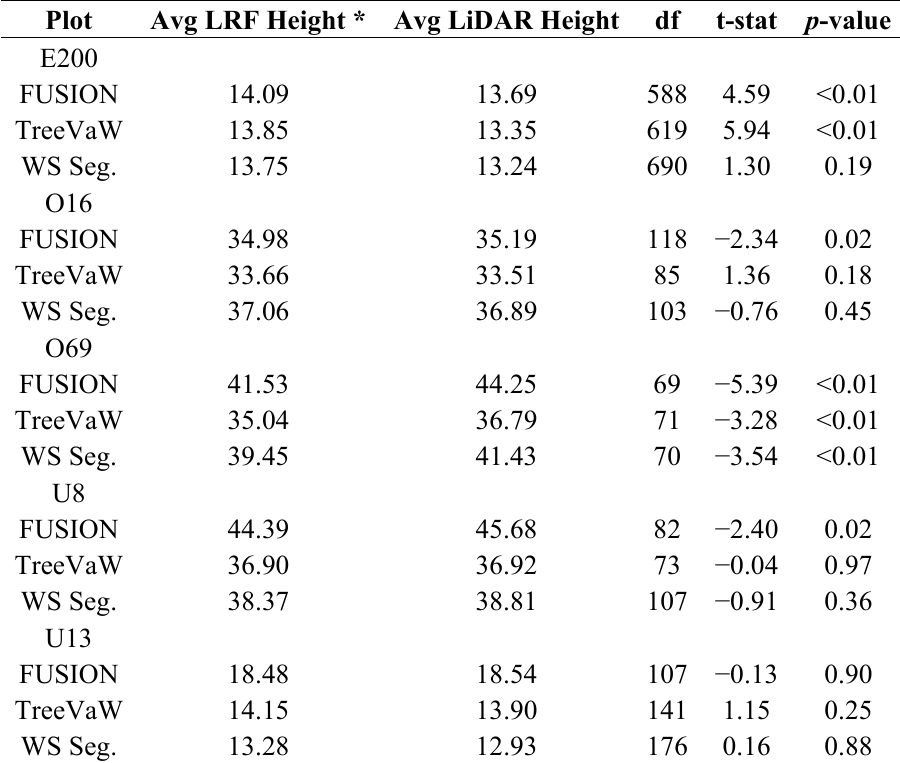
Table 9. Statistical comparison of paired LiDAR-derived tree heights to laser range finder (LRF) tree